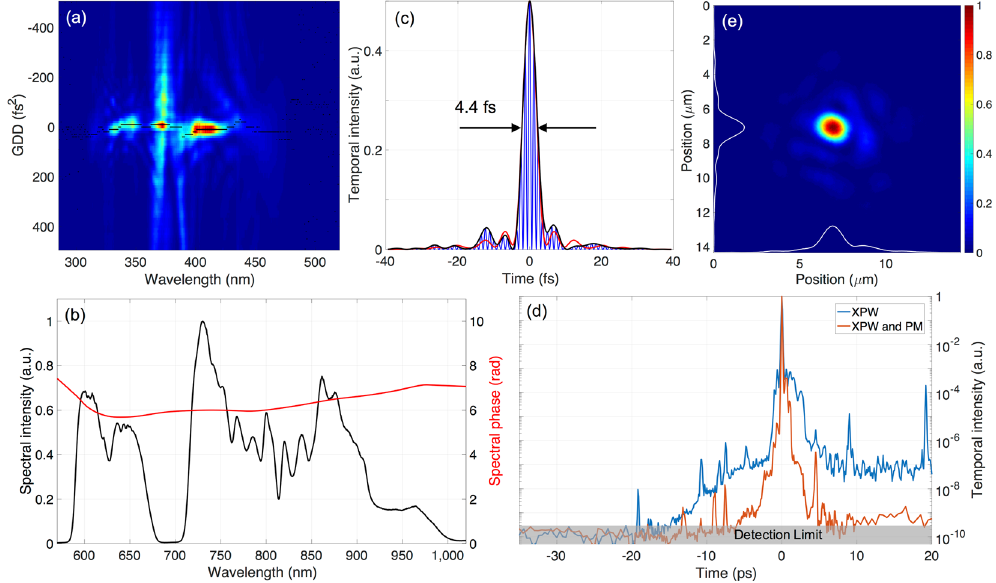
Figure 2. Spatio-temporal characterization. ( a ) Chirp-scan trace measured at one of the target experimental chambers, showing the second-harmonic spectral intensity as a function of wavelength and introduced GDD. The black curve shows the maximum harmonic intensity for each wavelength. ( b ) Retrieved spectral phase (red curve) and measured spectral intensity (black curve). ( c ) Temporal intensity (black curve), Fourier-limited intensity (red curve) and instantaneous intensity (blue curve) calculated from the chirp-scan retrieval. Both the evaluated and Fourier-limited durations are 4.4 fs. ( d ) Third-harmonic cross-correlation measurement of the temporal intensity with only XPW in use (blue dashed curve) or both XPW and the plasma mirror (PM) applied (orange solid curve). The detection limit of the device is approximately 10 − 10 . ( e ) Single shot image of the focus, obtained with a 60-mm-focal length off-axis parabolic mirror showing a FWHM diameter of 1.3 µ m, corresponding to a peak intensity of 1.3 × 10 20 W/cm 2